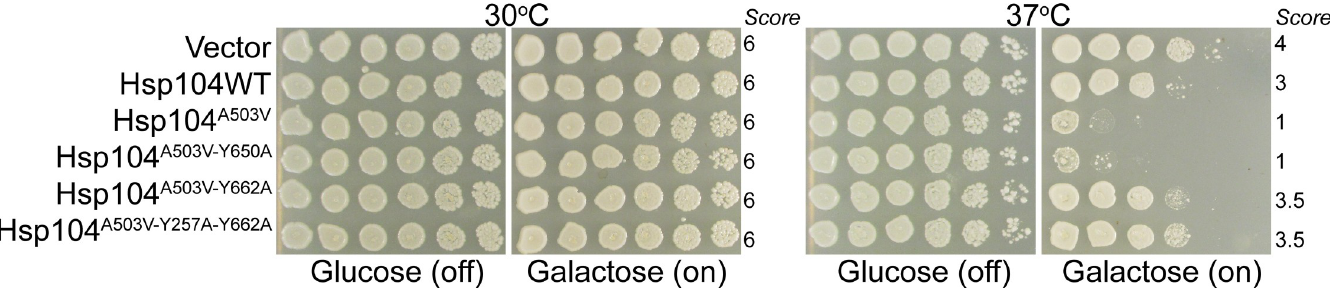
Fig 4. Ablation of substrate binding residue of putative pore loop does not abolish temperature sensitive phenotype of Hsp104 A503V . W303 Δ hsp104 yeast were transformed with the indicated 416GAL-Hsp104 plasmid or empty vector control. Yeasts were grown to saturation in synthetic raffinose medium, serially diluted, and spotted onto SD-Ura or SGal-Ura media and incubated at 30 or 37˚C. Plates were analyzed after 2–3 days of growth. Scores are based on number of spots (from 1 to 6), based on an average of three biological